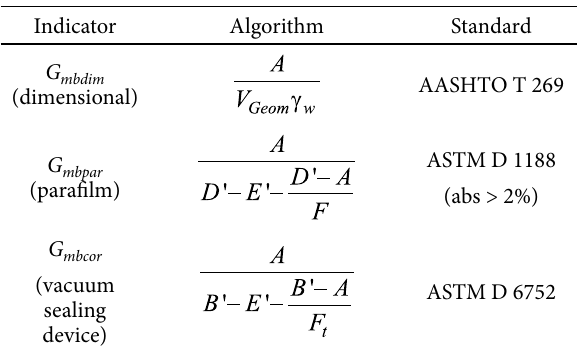
Table 1. Main procedures for G mb